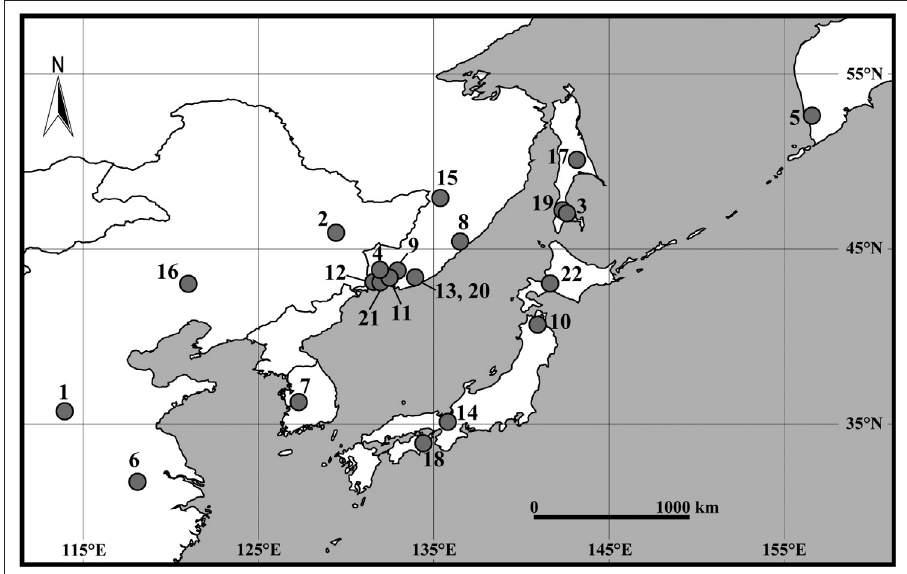
F igure 1. Distribution map of Pseudocrangonyx species. 1 Pseudocrangonyx elegantulus sp. n. 2 P.